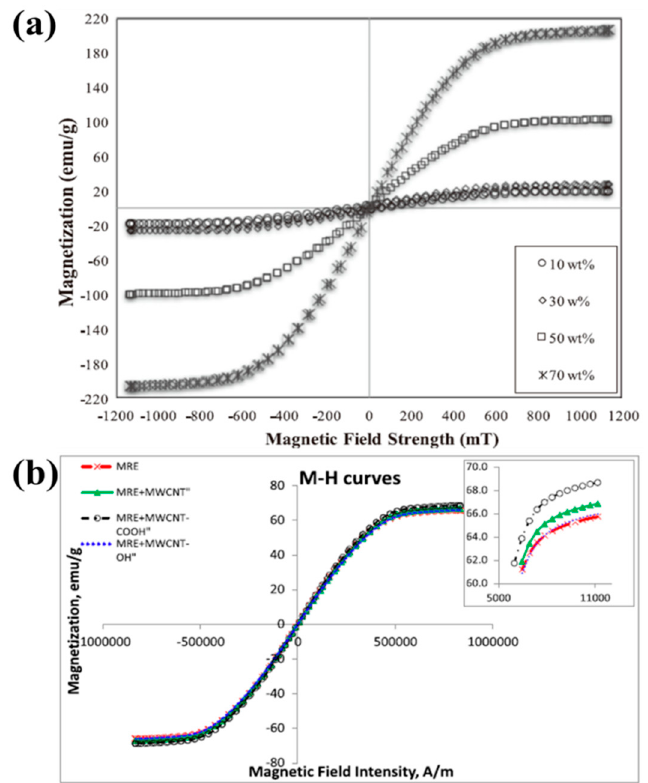
Figure 3. Magnetization curves of ( a ) the epoxidized NR (ENR)-based MR elastomers for different contents of CI particles (reprinted with permission from [85], Copyright 2016 IOP Publishing Ltd., Bristol, U.K.) and ( b ) the MR elastomers samples containing CNTs (reprinted with permission from [103], Copyright 2016 IOP Publishing Ltd., Bristol, UK).